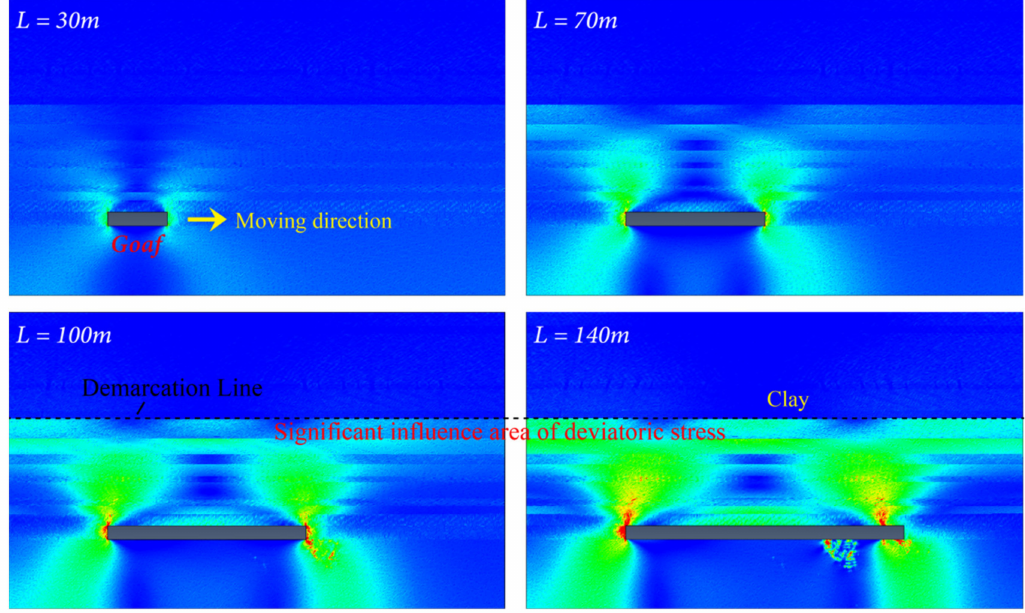
Figure 7. The variation pattern of the equivalent stress field with the advance of the working